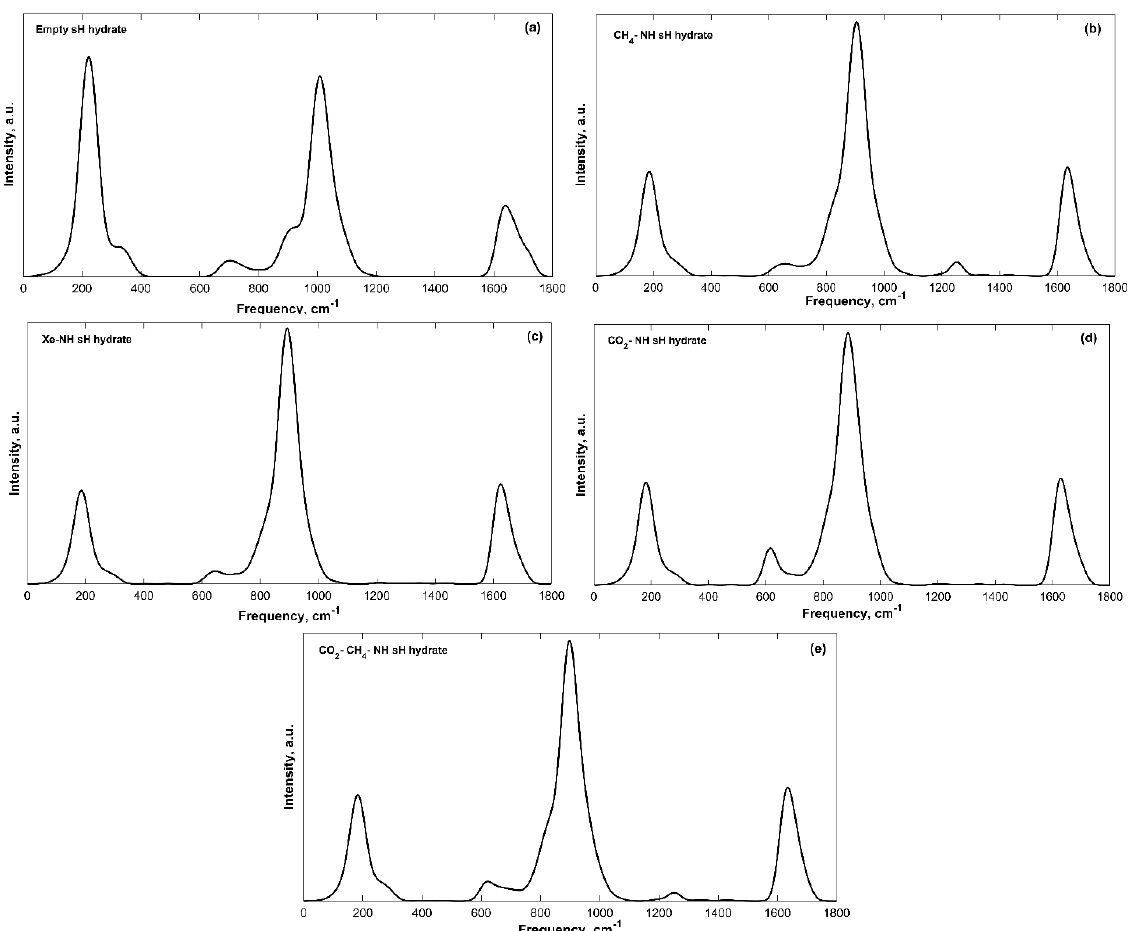
Figure 2. Low frequency convoluted IR spectra bands of sH gas hydrates at 0 K and 0 GPa. ( a ) Empty sH hydrate; ( b ) CH 4 -NH sH hydrate; ( c ) Xe-NH sH hydrate; ( d ) CO 2 -NH sH hydrate; ( e ) CO 2 -CH 4 -NH sH